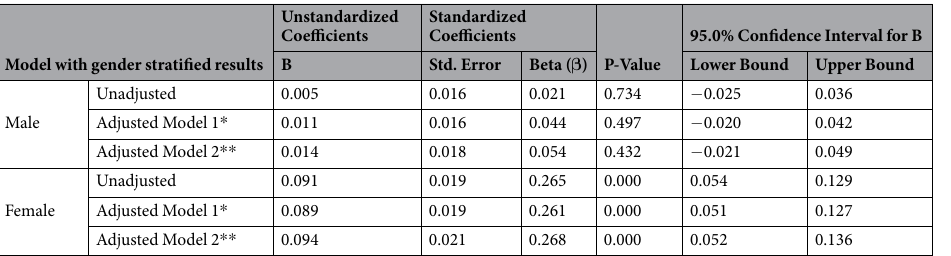
Table 4. Linear regression model partitioned by gender. * Adjusting for Age, Gender, Ethnicity, BMI, Tanner Stage, Batch Effect. ** Adjusting for Age, Gender, Ethnicity, BMI, Tanner Stage, Batch Effect, Physical Activity.